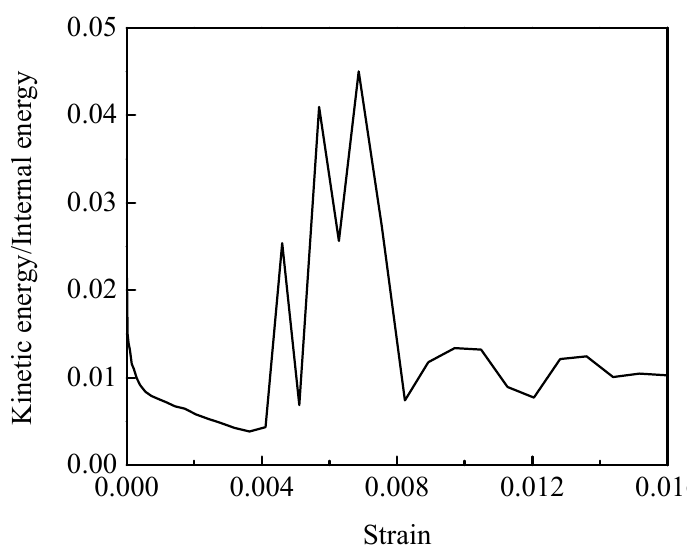
Figure 13. The ratio of kinetic energy to internal energy. Table 3. Calculated peak stress and failure strain.